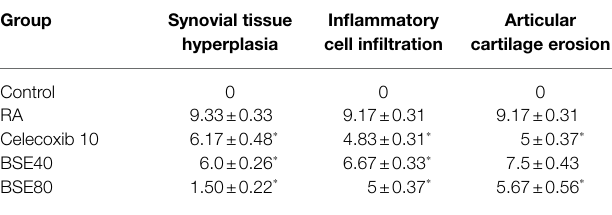
TABLE 1 | Histopathological scores of ankle issues. Group Synovial tissue